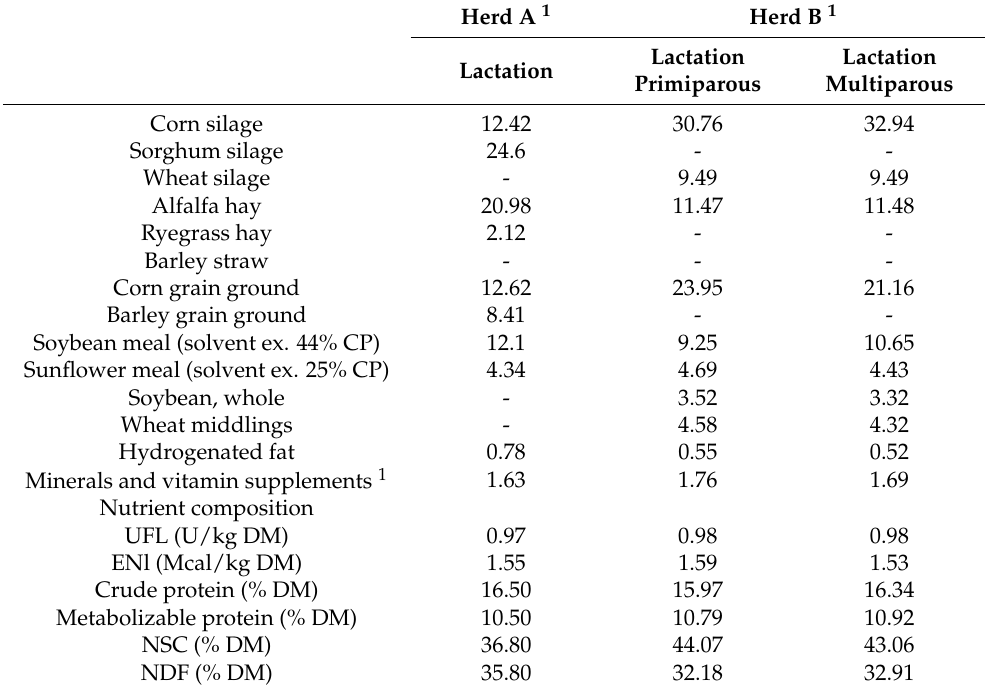
Table 1. Diet composition (% of DM) during lactation and the dry period in the two